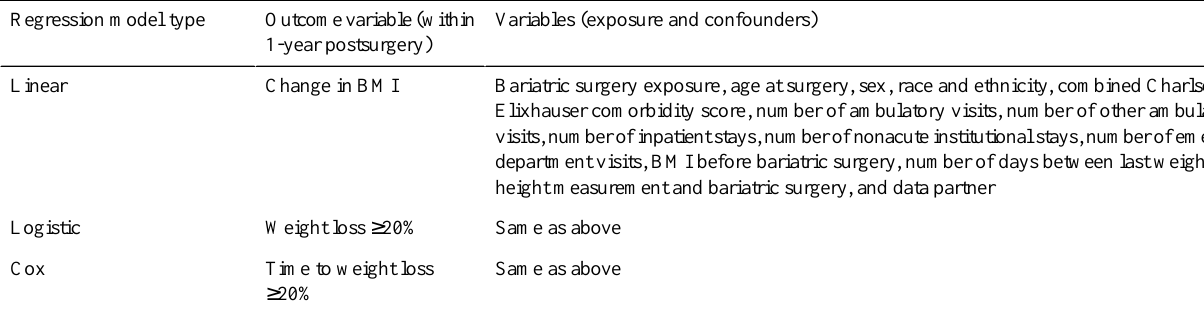
Table 1. Analytical datasets and variables. Variables (exposure and confounders)Outcome variable (within postsurgery)Regression model type 1-year Bariatric surgery exposure, age at surgery, sex, race and ethnicity, combined Charlson- Elixhauser comorbidity score, number of ambulatory visits, number of other ambulatory visits, number of inpatient stays, number of nonacute institutional stays, number of emergency department visits, BMI before bariatric surgery, number of days between last weight and height measurement and bariatric surgery, and